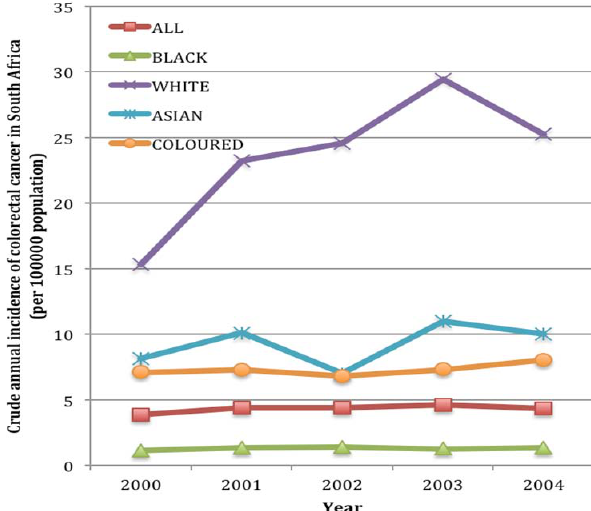
Figure 9 Crude incidence of colorectal cancer in South Africa (per 100 000 population) by ethnicity for 2000–2004.